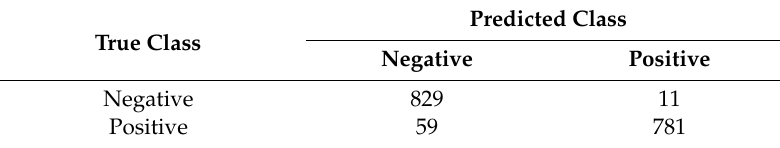
Table 5. Deep FC1 features and SVM classifier.